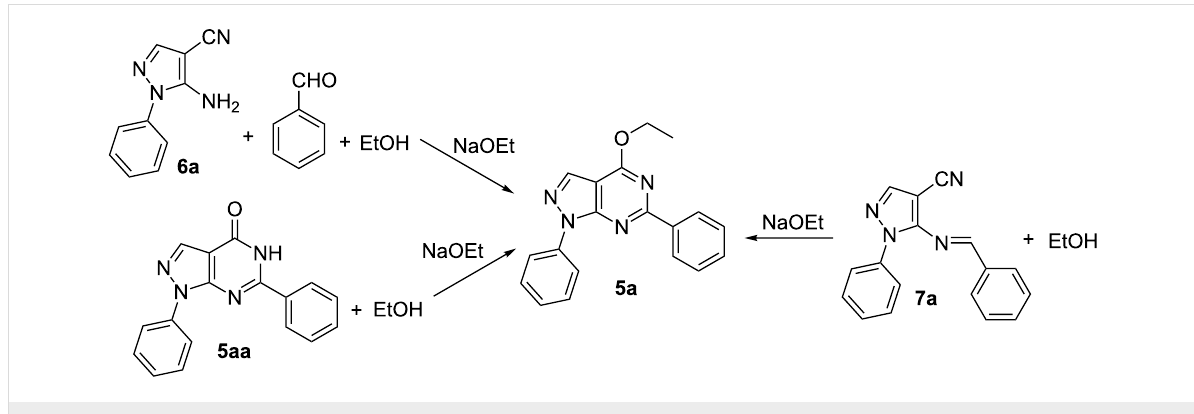
Scheme 2: Synthesis of 5a from different intermediates.